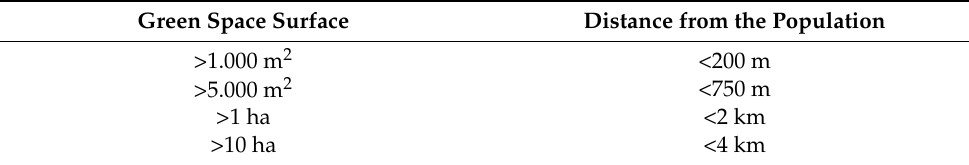
Table 4. Conditions and values set for the calculation of the P green